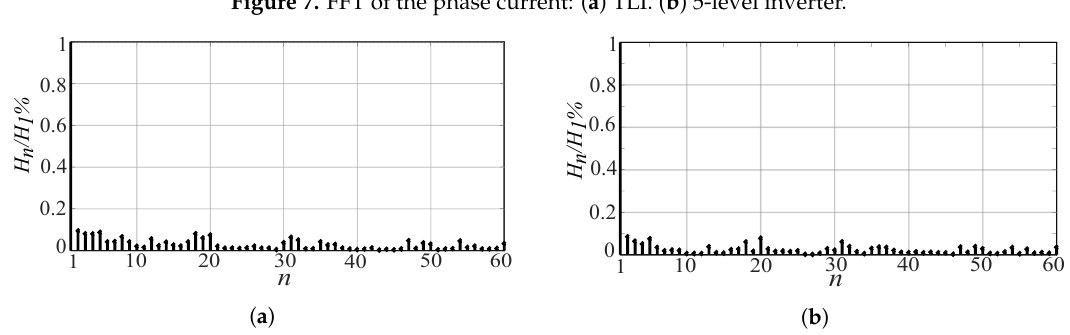
Figure 7. FFT of the phase current: ( a ) TLI. ( b ) 5-level inverter.